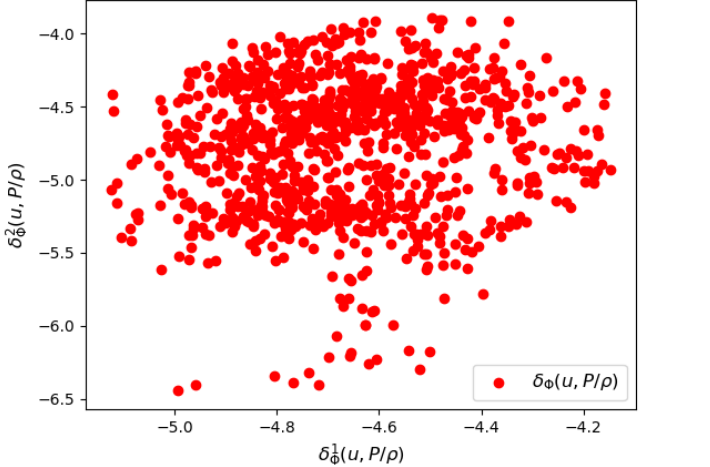
Figure 23. The first two components of the parametrized logarithm of variance by the VAE encoder.